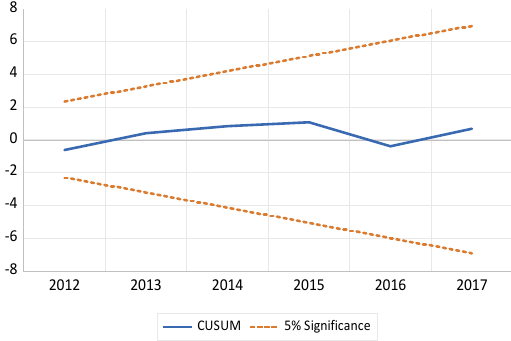
Figure 5. COSUMQ test for the nonlinear ARDL model.